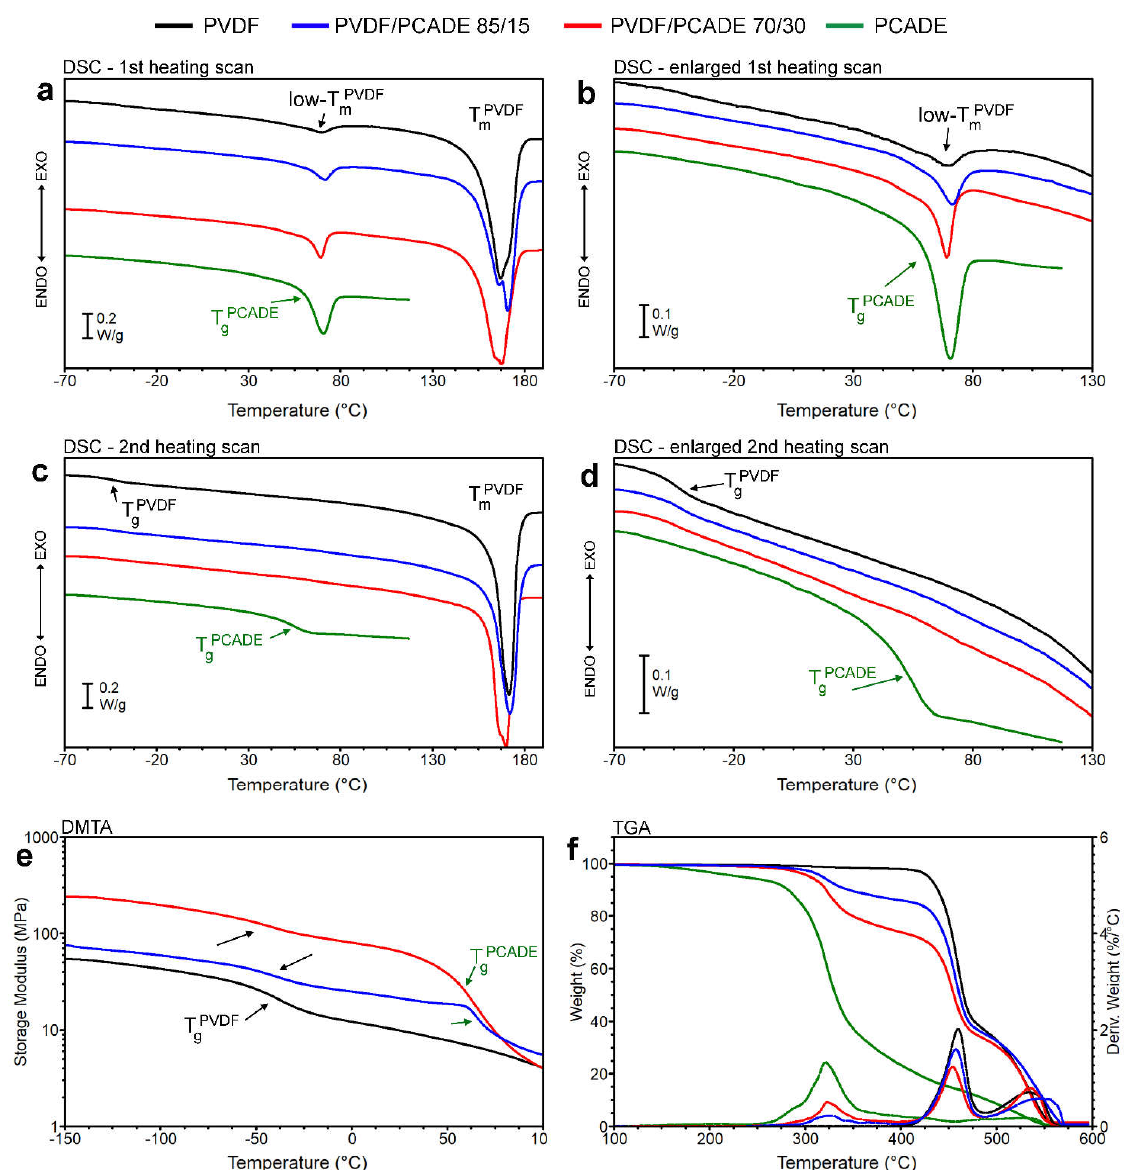
Figure 3. Thermal analysis of electrospun mats. ( a , b ) DSC first heating scans; ( c , d ) DSC second heating scans after quench; ( e ) storage modulus as a function of temperature determined by DMTA analysis; ( f ) weight loss and its corresponding derivative as a function of temperature determined by TGA analysis. PVDF = black, PVDF/PCADE 85/15 = blue, PVDF/PCADE 70/30 = red and PCADE powder =green. Thermal transitions ascribable to the PVDF phase are indicated with black arrows, whereas those of PCADE with green arrows.